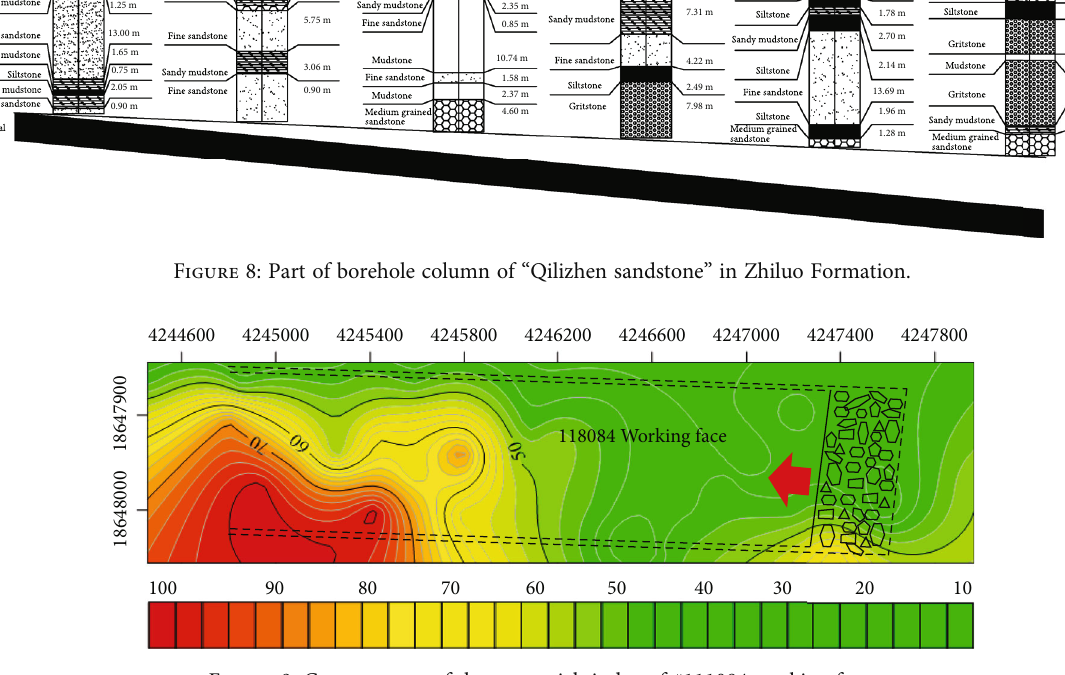
Figure 9: Contour map of the water-rich index of #111084 working